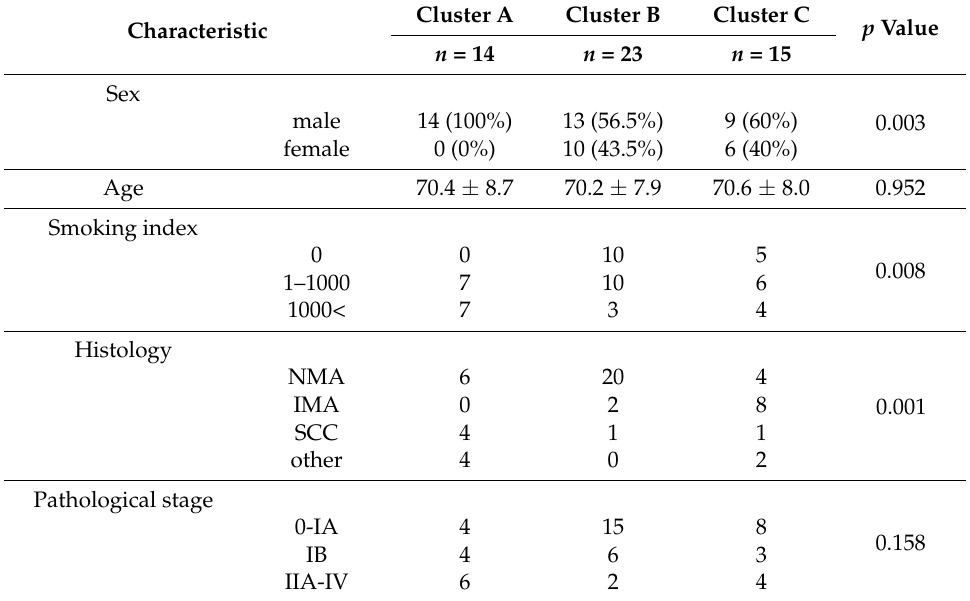
Table 2. Characteristics of genomic